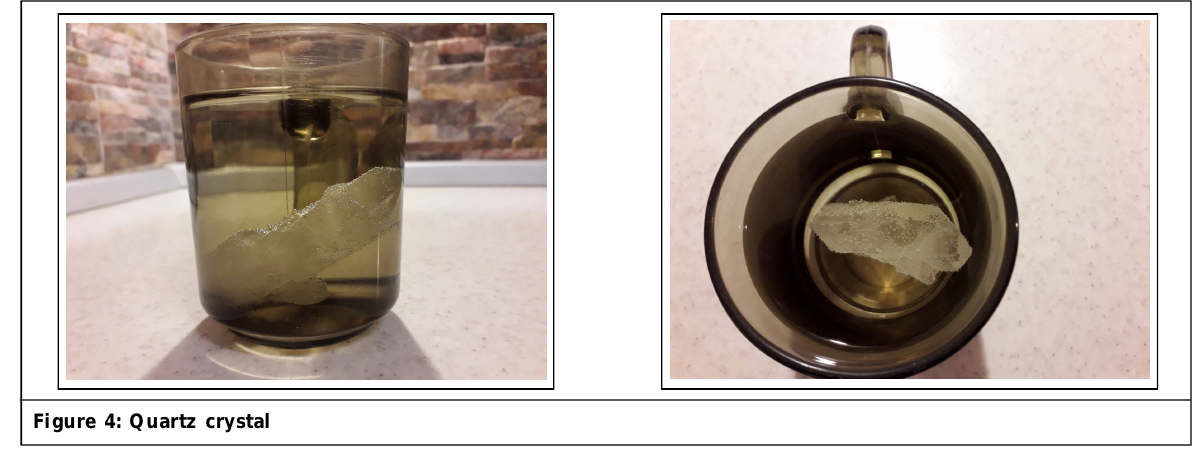
poleSiberian Colia, the south magnetic pole